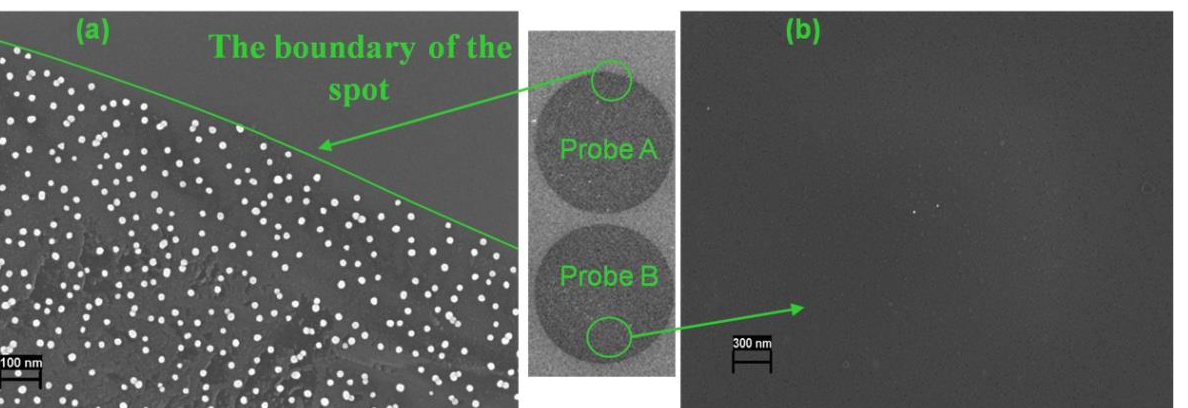
Figure 2. Schematic representation of hybridization of biotin-labeled short target oligonucleotides ( a ) and long target DNA ( b ) on silicon DNA microchips. — capture oligonucleotide probes immobilized on the microchip surface,